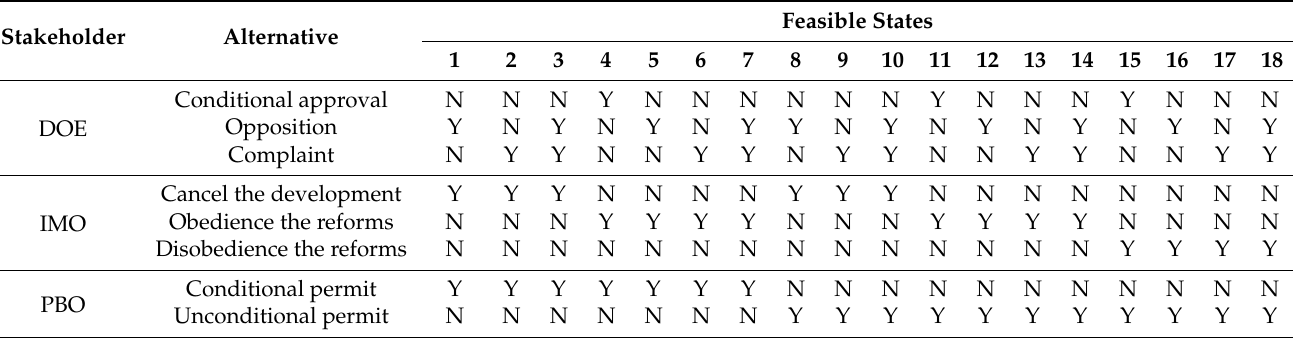
Table 4. Preference rating of possible conflict situations for each stakeholder from maximum to Table 3. Feasible states in the industrial development of Markazi province. minimum.